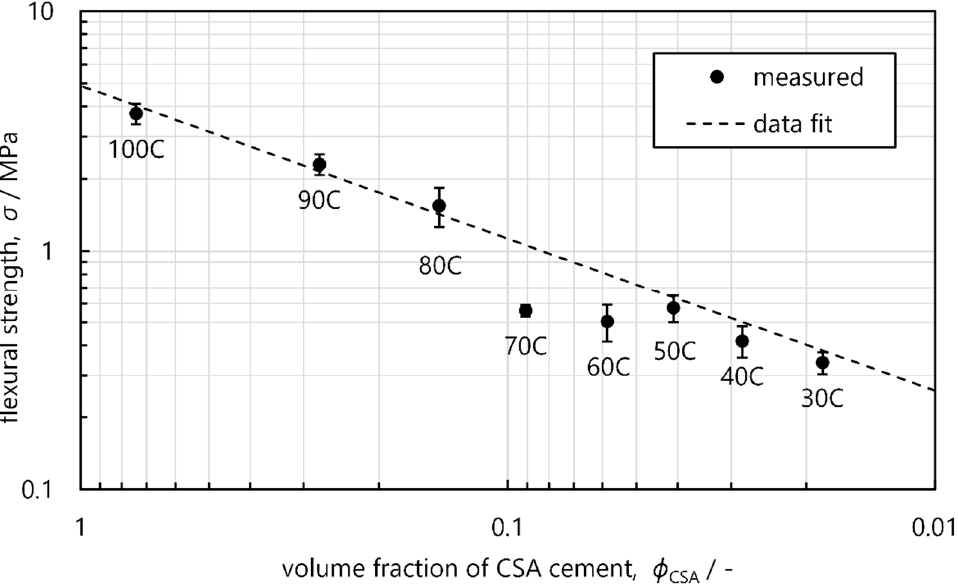
Figure 7. Three ‐ point bending tests of the hydrated specimens. The specimens were tested after 14 days of hydration in a wet state. For each sample composition, six prisms were tested ( N = 6). Data fit to f( ϕ ) = a 0 + a · ϕ v , with a 0 = 0, a = 4.892, and υ = 0.638. Table 4. Flexural strength and thermal conductivity for all mixtures.